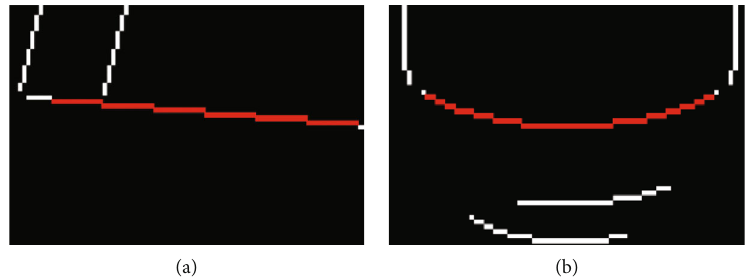
Figure 4: Extraction of image features. The line and arc detected are marked in red, respectively, in (a) and (b).